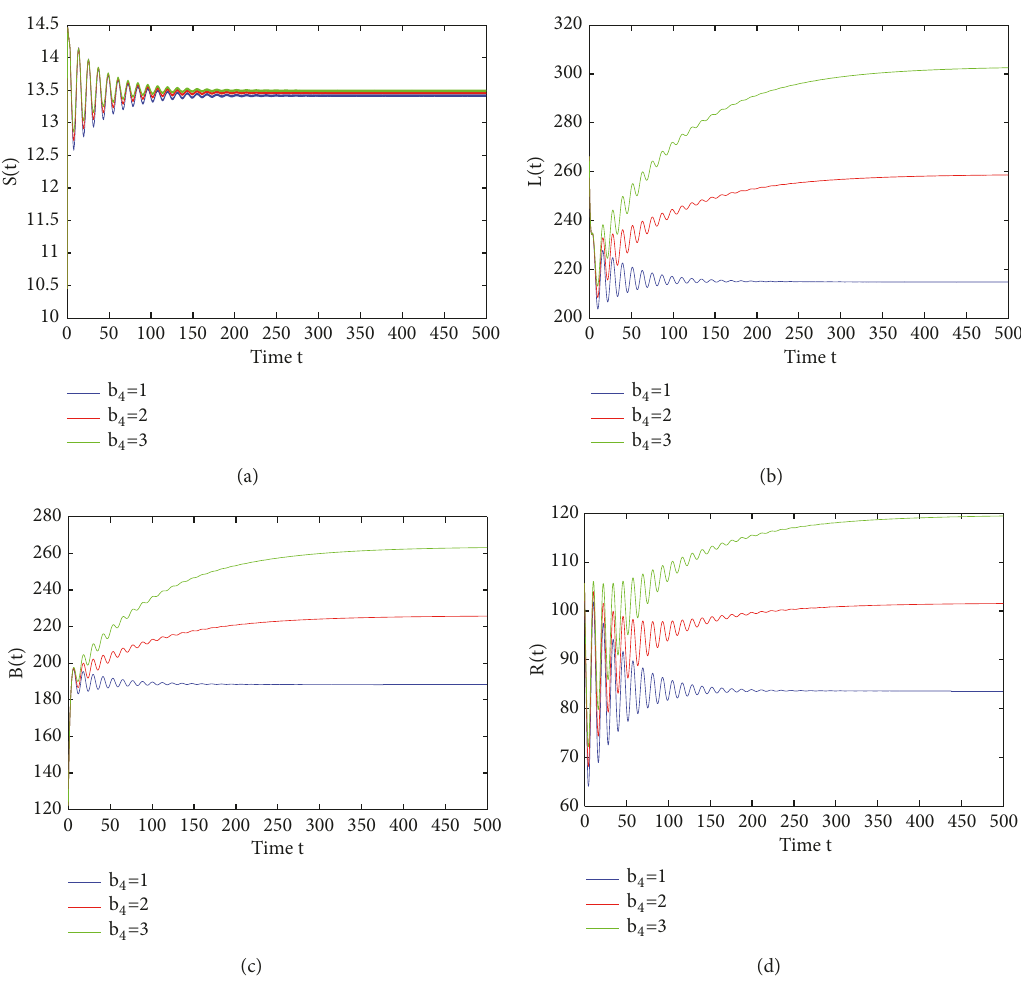
Figure 14: Time plots of 𝑆 , 𝐿 , 𝐵 , and 𝑅 for different 𝑏 3 at 𝜏 = 3.2575 . Rest of the parameters are taken as given in the